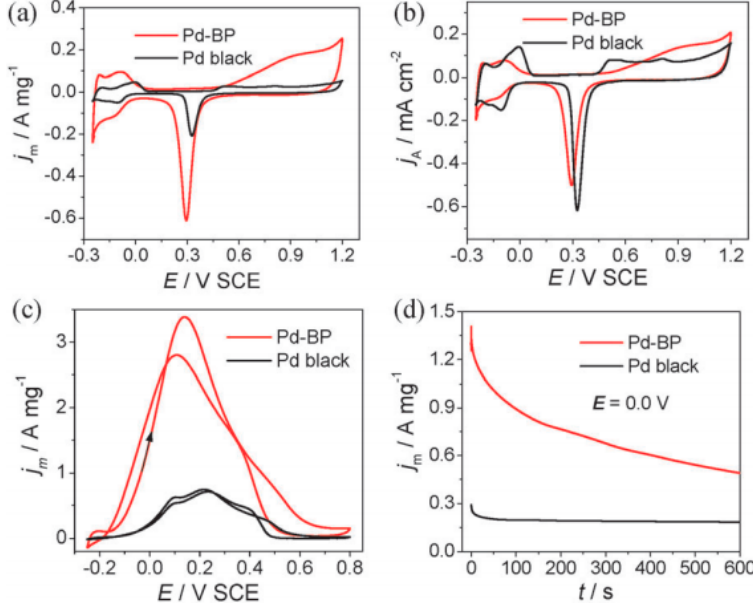
Figure 5. Cyclic voltammograms of butylphenyl-functionalized Pd (Pd-BP) nanoparticles and commer-cial Pd black in 0.1 M H 2 SO 4 , with the currents normalized ( a ) by the mass loadings of Pd and ( b ) by the effective electrochemical surface areas at a potential scan rate of 100 mV s − 1 ; Panels ( c ) and ( d ) depict the cyclic voltammograms and current-time curves acquired at 0.0 V for HCOOH oxidation, respectively, at the Pd-BP nanoparticles and Pd black-modified electrode in 0.1 M HCOOH + 0.1 M H 2 SO 4 at room temperature. Reproduced with permission from reference